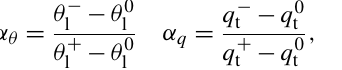
Figure 4. As in Fig. 2 but for flight no. 14. Line styles of the PROFs are consistent with the figures in the following sections. PROF1–PROF3 are all marked with dashed lines because their alti- tude ranges do not